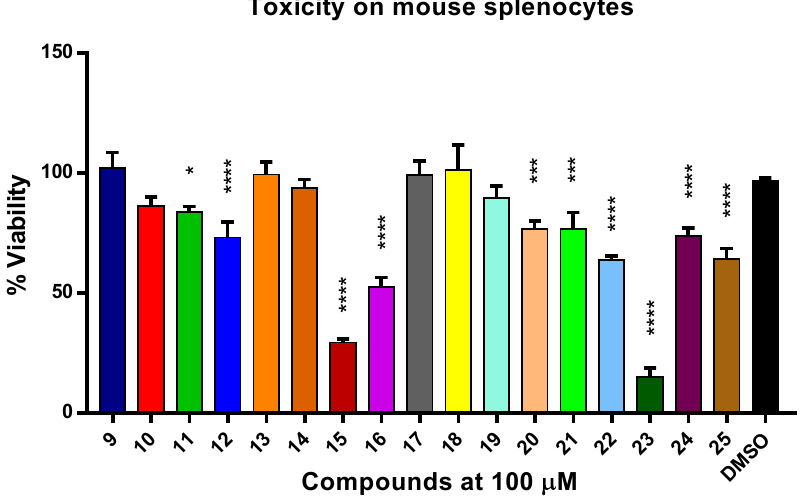
Figure 4. Toxicity of compounds 9 – 25 to murine splenocytes (BALB/c mice). Statistical significance was determined in comparison to the untreated control. * = p < 0.05; *** = p < 0.001; **** = p < 0.0001.